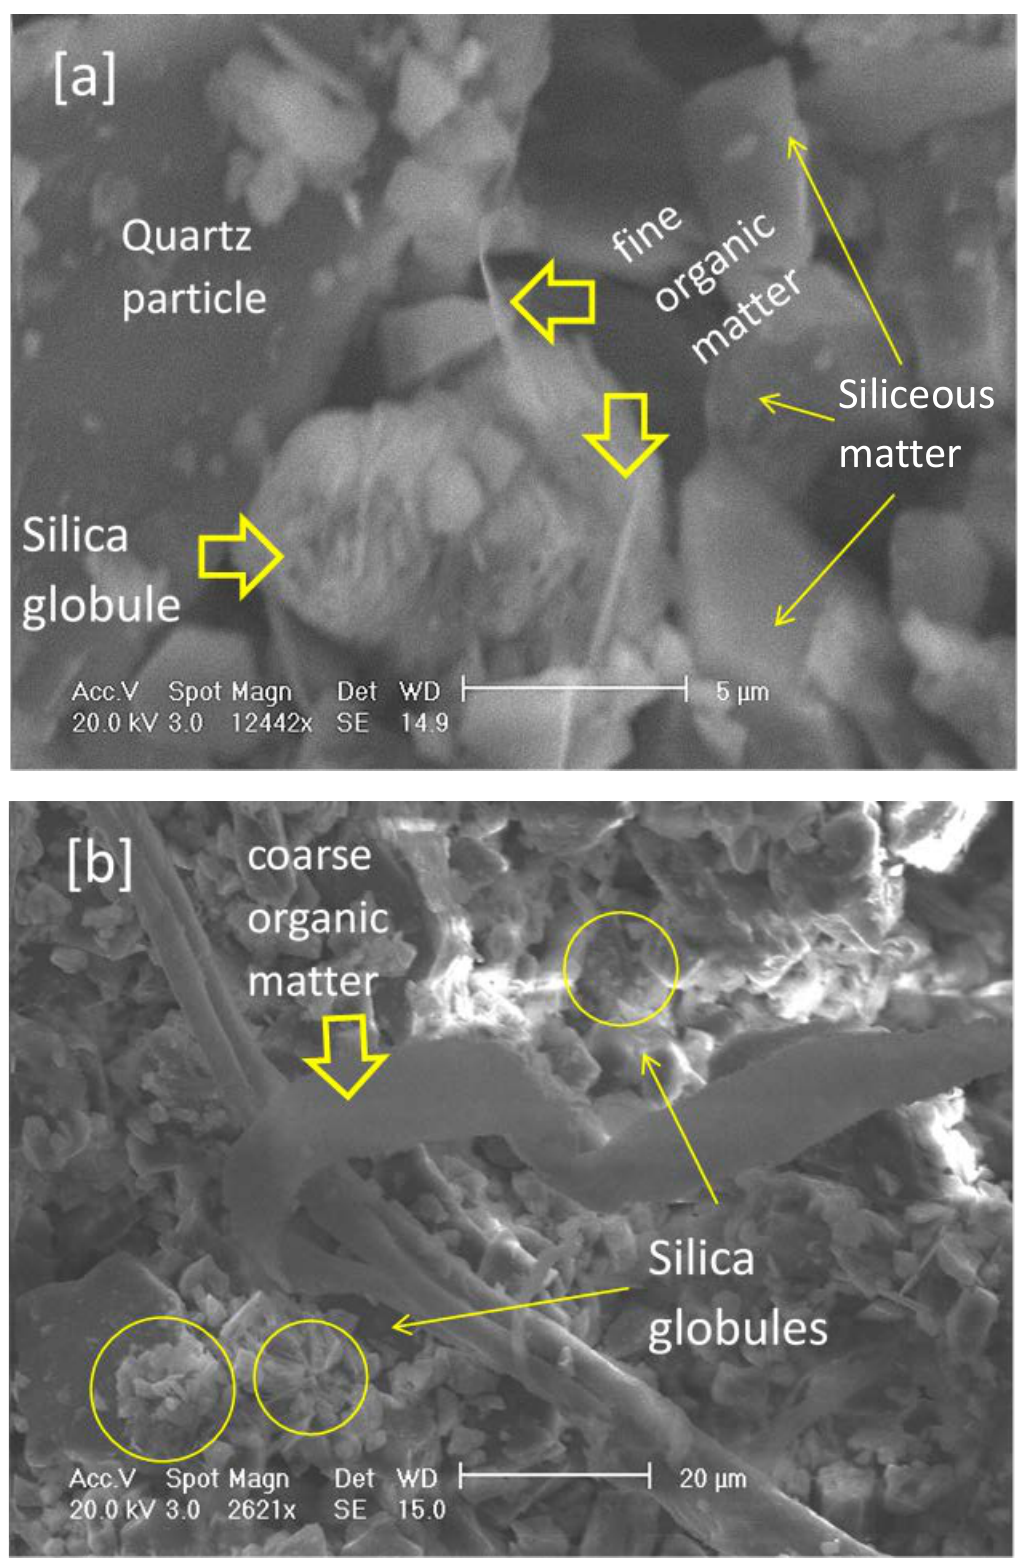
Figure 4. Two SEM micrographs of modified peat specimens: [a] basic elemental level at 12000× magnification, showing the perturbed plates within the rounded silica globules surrounded by a suite of organic and siliceous solid matter; [b] domain level at 2000× magnification, showing the morphology of fibrous organic matter and larger silica coagulates in between domains of siliceous solid matter and macro- pore